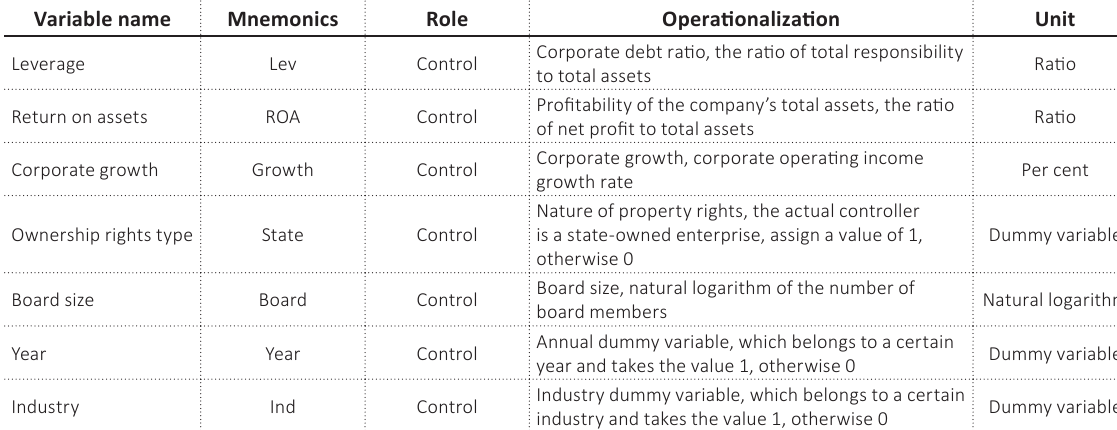
Table A2 (cont.). Description of variables used in the